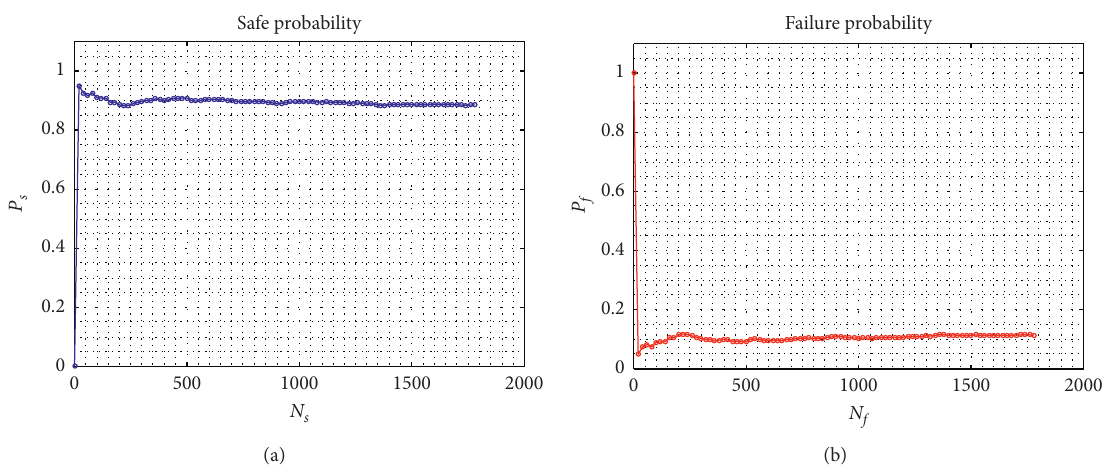
Figure 14: Convergence of the safe probability of the 50-year corroded SCC